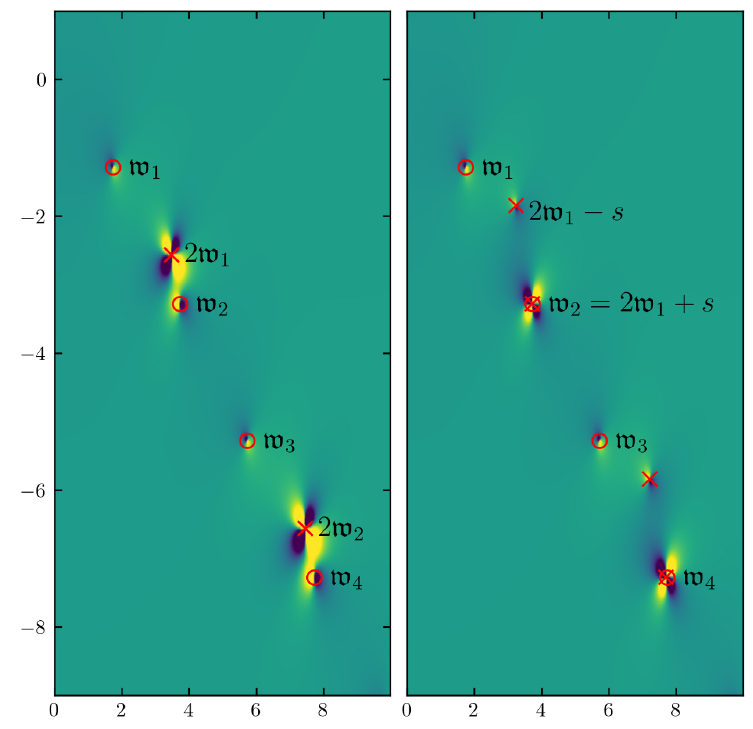
Figure 4 . The retarded three-point function, Re r 3 ( p 1 , p 2 ) , shown at zero spatial momentum p i = p i = 0 in the complex plane of the total driving frequency, p = p 0 + p 0 , with a carefully chosen 1 2 1 2 fixed frequency difference s ≡ p 0 − p 0 . Circles correspond to resonant excitations of QNMs through 1 2 bulk interactions, while crosses correspond to direct driving of QNMs by the external momenta. Left panel : s = 0 . Here all QNMs excited by direct driving collide with each other giving a sequence of order-two poles, where the two incoming legs of the diagram are on QNM frequencies. Right panel : s = w 2 − 2 w 1 which has been chosen to illustrate another sort of singularity, where a directly driven mode collides with a resonant excitation at p = w 2 (i.e. at p 1 = w 2 − w 1 , p 2 = w 1 ). Thus here the outgoing leg is at w 2 and one incoming leg is at w 1 . Note that apparent coincidence of poles near w 4 is only approximate; this is still a pair of simple